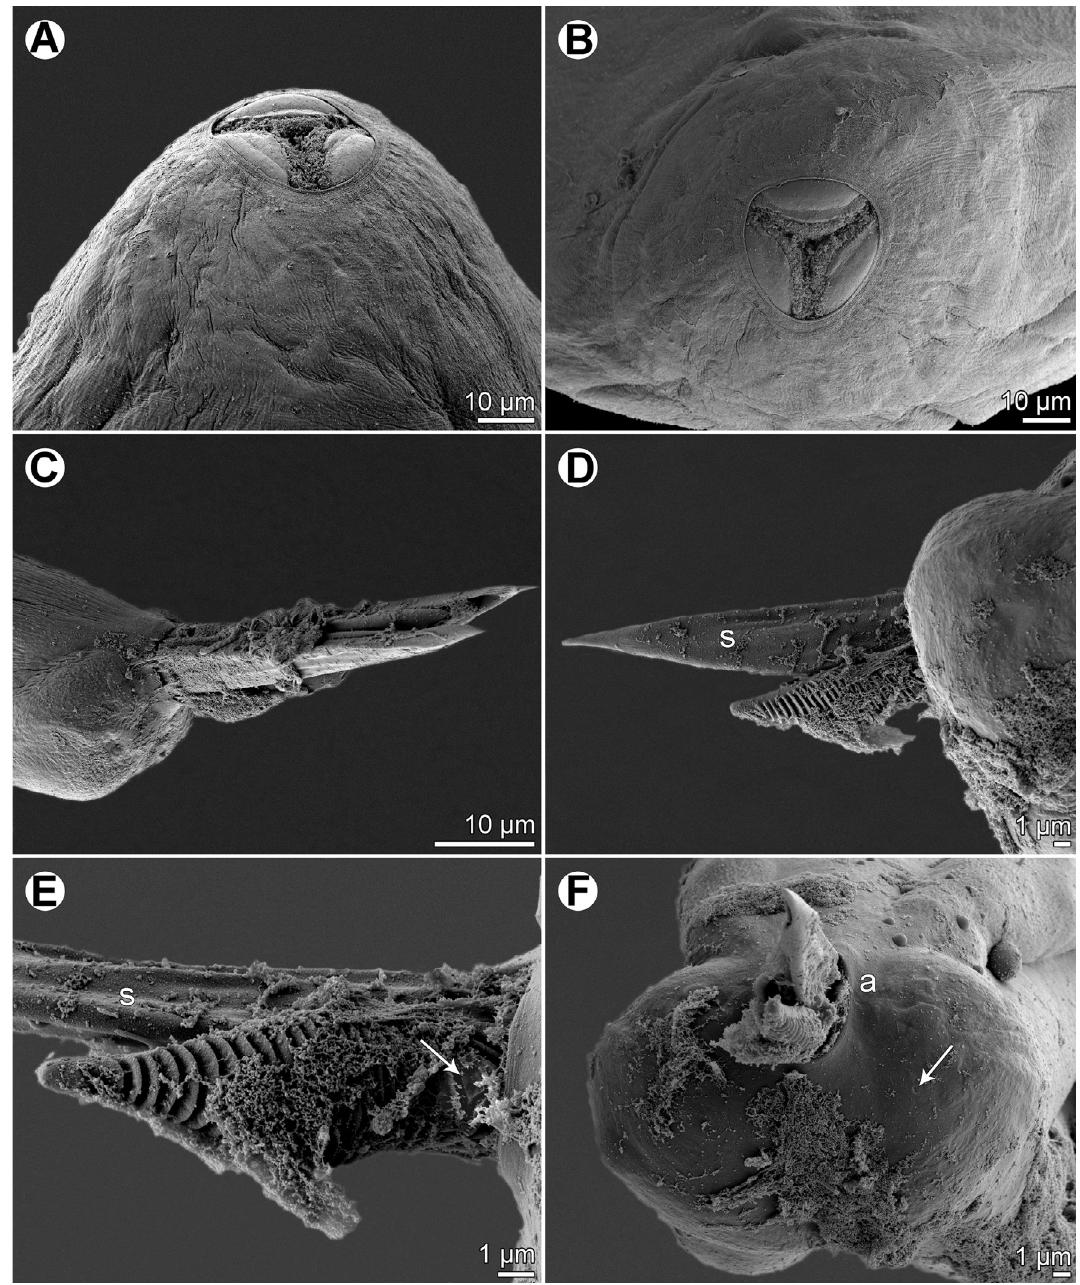
Figure 2. Philometra protonibeae n. sp. from Protonibea diacanthus , scanning electron micrographs. A, B: cephalic end of subgravid female, subapical and apical views. C: Caudal end of male with protruded spicules and gubernaculum, lateral view. D: Protruded distal ends of spicule and gubernaculum, lateral view. E: Distal end of gubernaculum, dorsal view (arrow indicates elevated triangular structure). F: Caudal end of male, apical view (arrow indicates phasmid). Abbreviations : a, group of four flat caudal papillae; s,